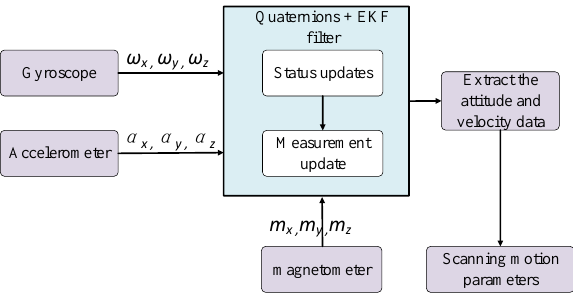
Figure 3. Block diagram of the scanning motion parameter estimation algorithm.